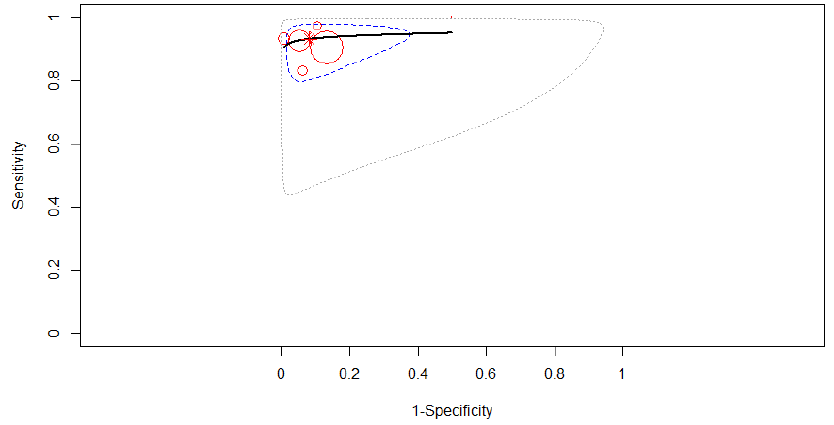
Figure 6. The SROC curve for conventional computer-aided diagnosis.